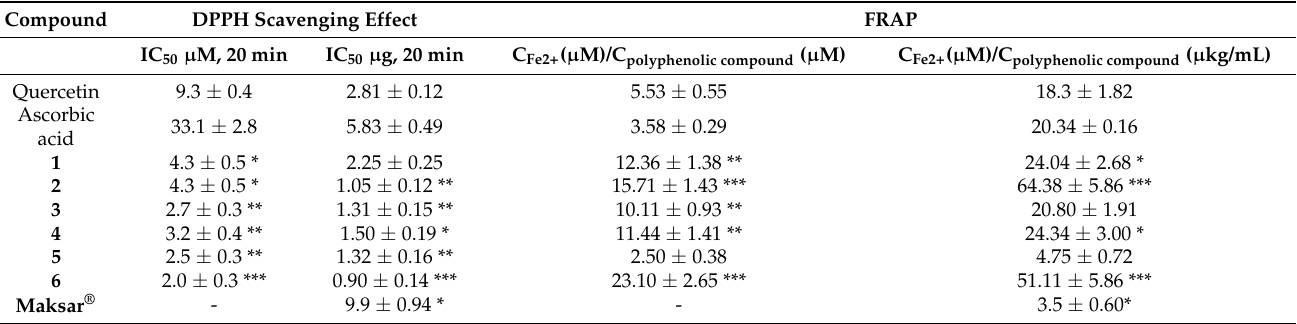
Table 3. DPPH scavenging activity and FRAP of compounds 1 – 6